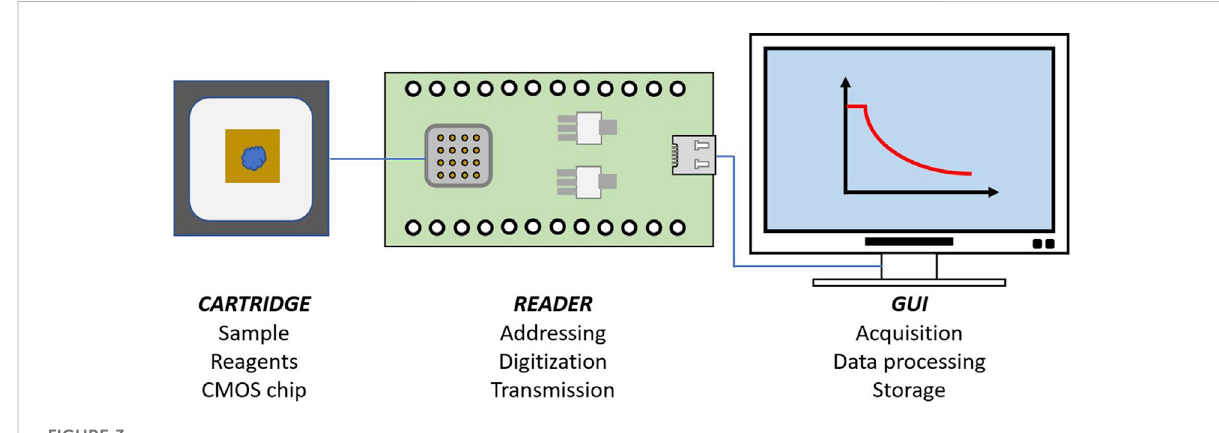
FIGURE 3 Illustration of the sensing platform. It combines a silicon (CMOS) based sensor chip on a disposable cartridge, a reader and a computing platform with